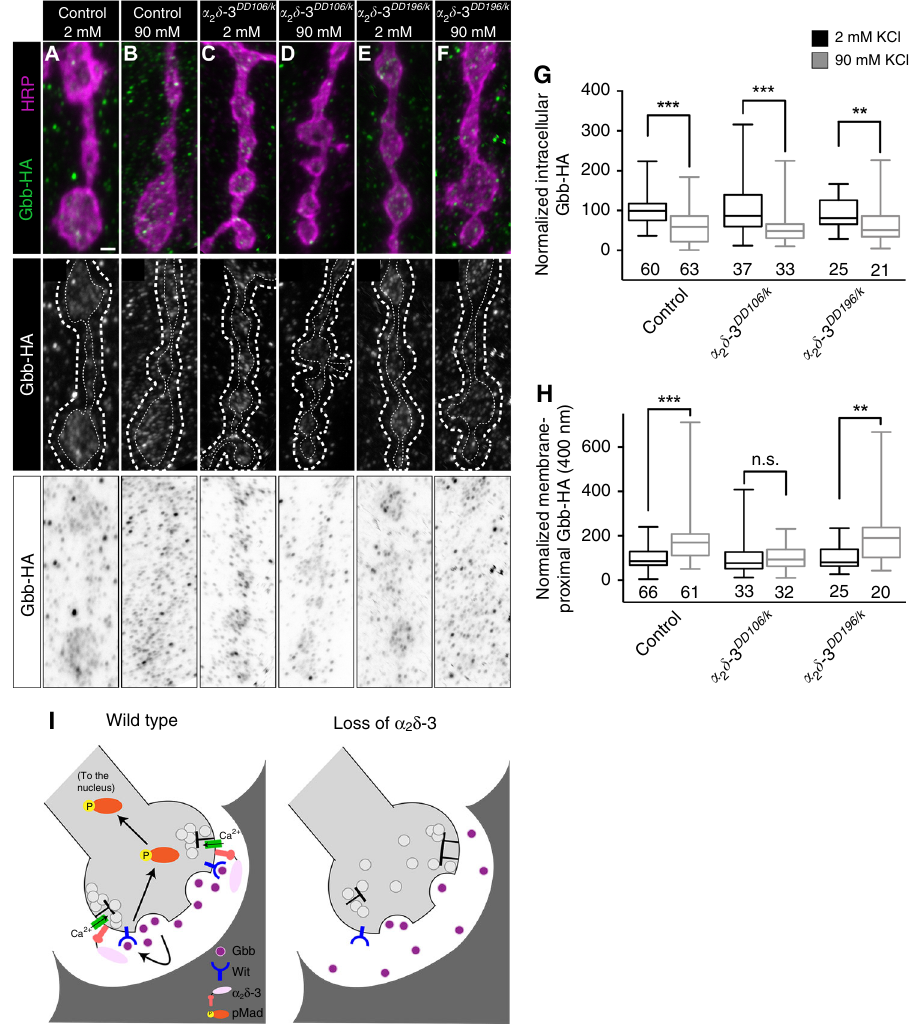
Fig. 10 α 2 δ -3 limits diffusion of Gbb following its activity-dependent release. a – f Top: representative z -projections of boutons of the indicated genotypes labeled with HRP (magenta) and Gbb-HA (green). Genotypes speci fi cally are: control (D42>gbb-HA) , α 2 δ -3 DD106/k ( α 2 δ -3 DD106/k10814 ; D42>gbb-HA) , and α δ -3 DD196/k ( α δ -3 DD196/k10814 ; D42>gbb-HA) . Scale bar: 1 µ m. Middle: individual Gbb-HA channel shown in grayscale. Membrane-proximal Gbb-HA was 2 2 measured between the two dashed white lines. Bottom: individual Gbb-HA channel with inverted colors. g Quanti fi cation of intracellular Gbb-HA normalized to control levels before (2 mM KCl) and after (90 mM KCl) neuronal stimulation. For all Gbb-HA release experiments, n is the number of NMJs scored. h Quanti fi cation of membrane-proximal Gbb-HA (within 400nm) normalized to control levels before and after neuronal stimulation. n.s. not signi fi cantly different. ** p < 0.01; *** p < 0.001 by a two-tailed Mann – Whitney test. i Proposed model for α 2 δ -3 acting as a physical barrier to promote Gbb signaling. Upon release from the neuron, Gbb is released into the synaptic cleft. With the aid of α 2 δ -3, Gbb remains in close proximity to the presynaptic membrane and is then able to activate the BMP Type II receptor Wit. The receptor complex in turn phosphorylates the transcription factor Mad, transducing a BMP signal back to the nucleus of the